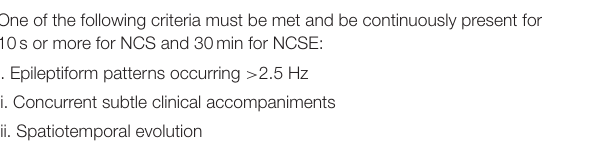
TABLE 1 | The Salzburg criteria for the diagnosis of NCSE (48). One of the following criteria must be met and be continuously present for 10s or more for NCS and 30min for